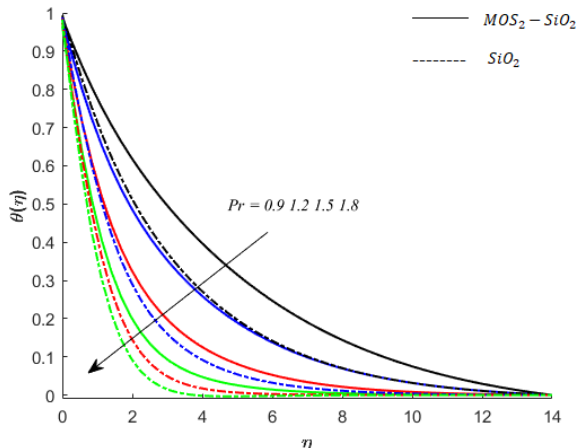
Figure 9. Influence of 𝑃𝑟 on temperature when 𝑀 = 0.9, 𝐸𝑐 = 0.2, 𝑆𝑐 = 0.8, 𝐾 = 0.1, 𝐸𝑖 = 0.1, 𝐵𝑖 = 0.05, 𝛽 ∗ = 0.1, 𝛾 = 0.1, 𝛾 = 0.1 .